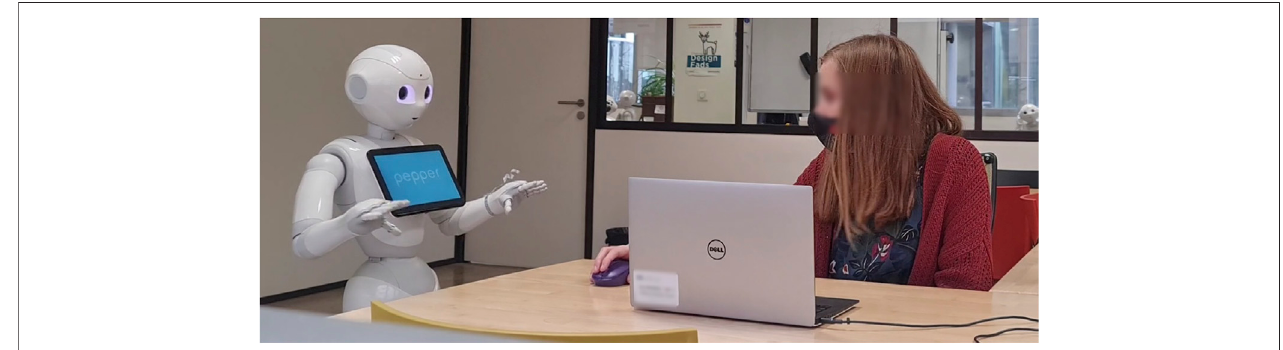
FIGURE4| Setupoftheexperiment. Participant sits infront ofalaptopand therobotisplacednexttotheuser.Theysharethespaceastherobotislookingat the screen over the participants.